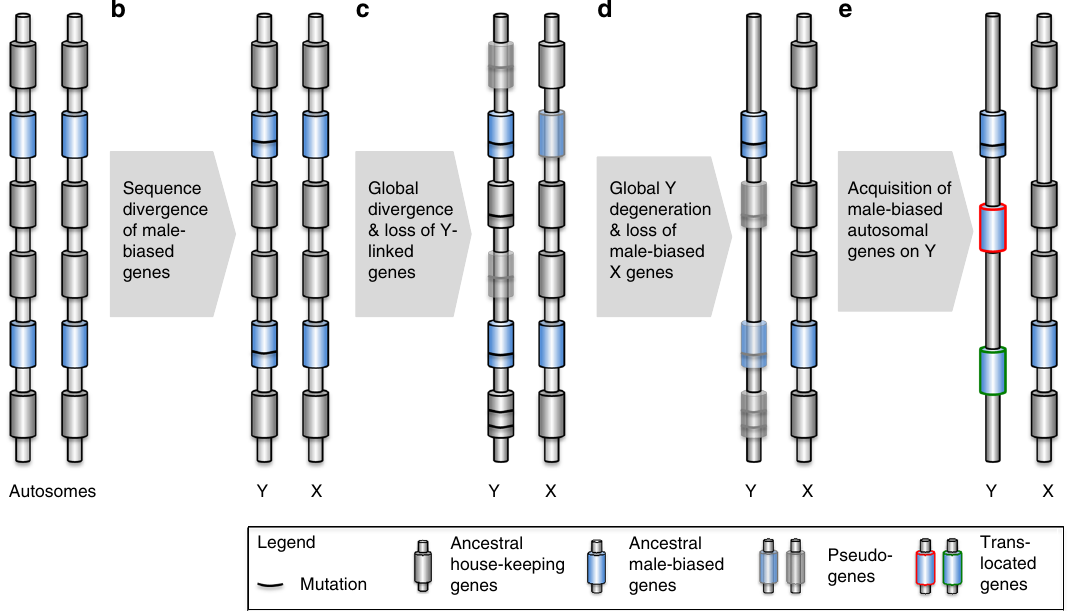
Fig. 7 Model of Y-linked gene content evolution in fl ies. The dynamics of gene content evolution in fl ies across time is shown. a X and Y chromosomes originate from ordinary autosomes with identical gene content. b The fi rst genes to diverge at the DNA sequence level are genes with male-biased expression. c Over time, most genes on the Y acquire mutations, and many start to become pseudogenes. d Continuing Y degeneration, and loss of some male-biased genes on the X chromosome. e Acquisition of male-biased genes from autosomes to the Y chromosome. Genes with male-biased expression are shown by blue shading , and genes with broad functions are shown with grey